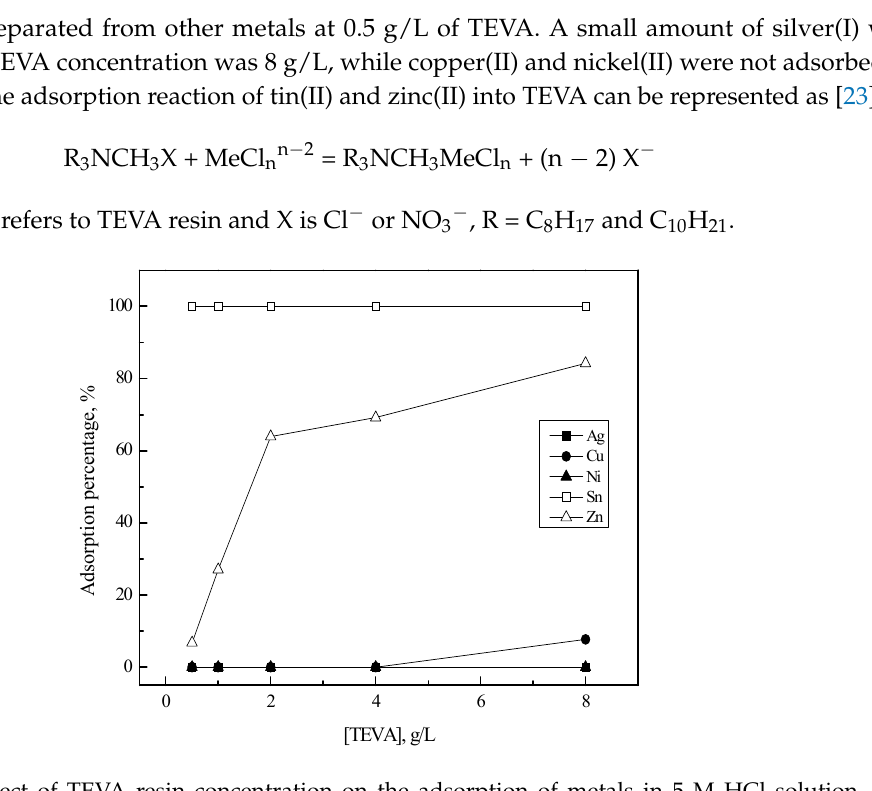
Figure 6. Effect of TEVA resin concentration on the adsorption of metals in 5 M HCl solution. [TEVA] = 0.5–8 (g/L), time = 6 h, shaking speed = 200 rpm.